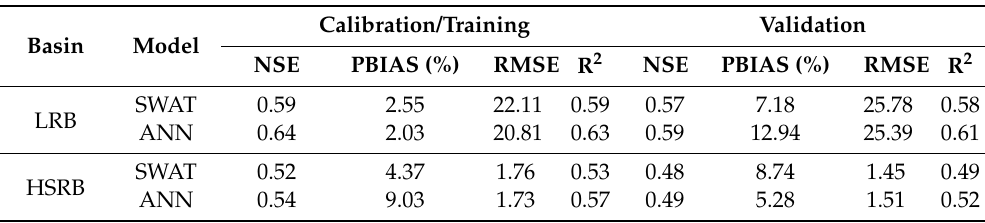
Table 9. Performances of SWAT and ANN